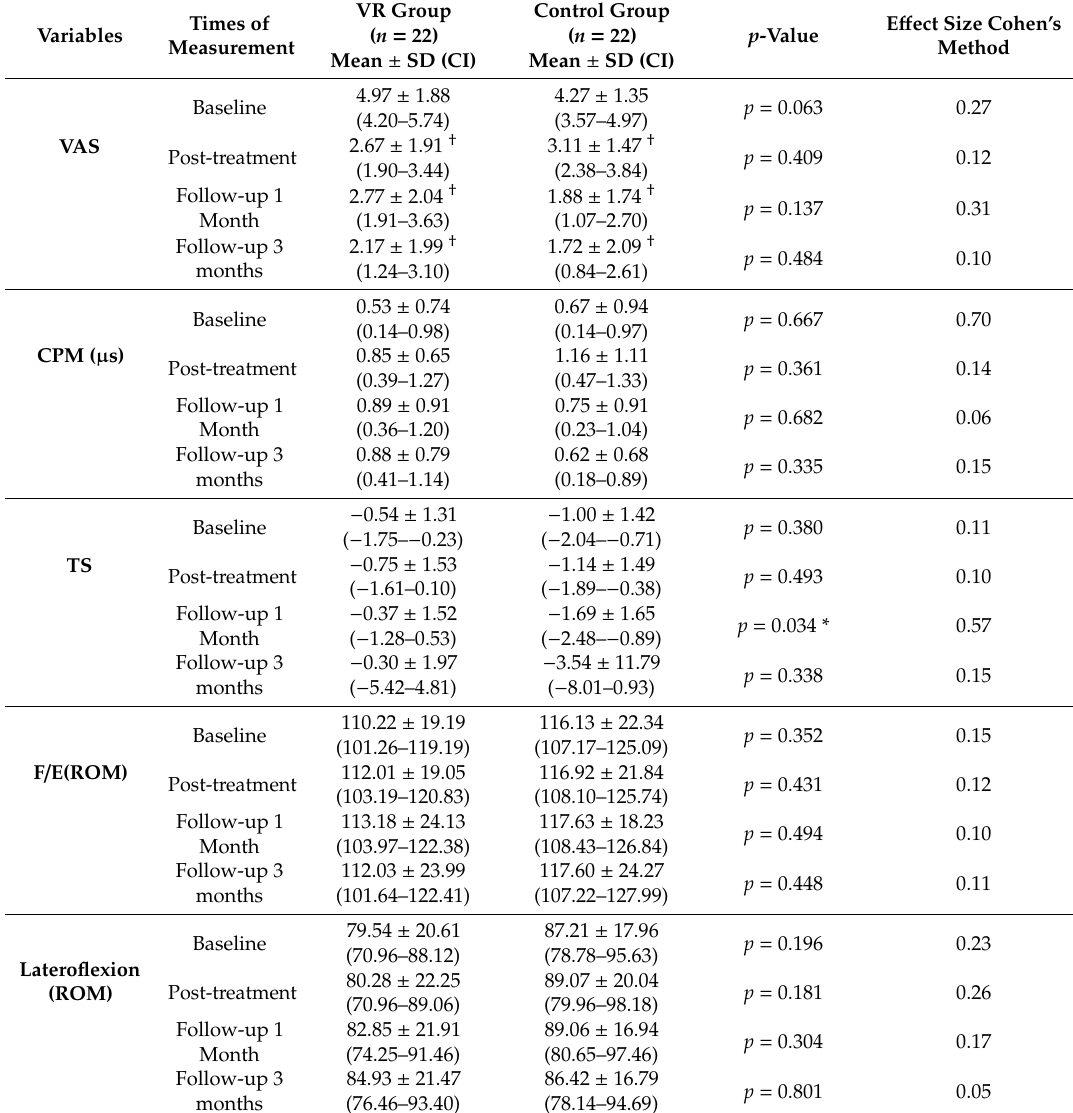
Table 2. Mean ± SD in primary and secondary outcomes and comparison between